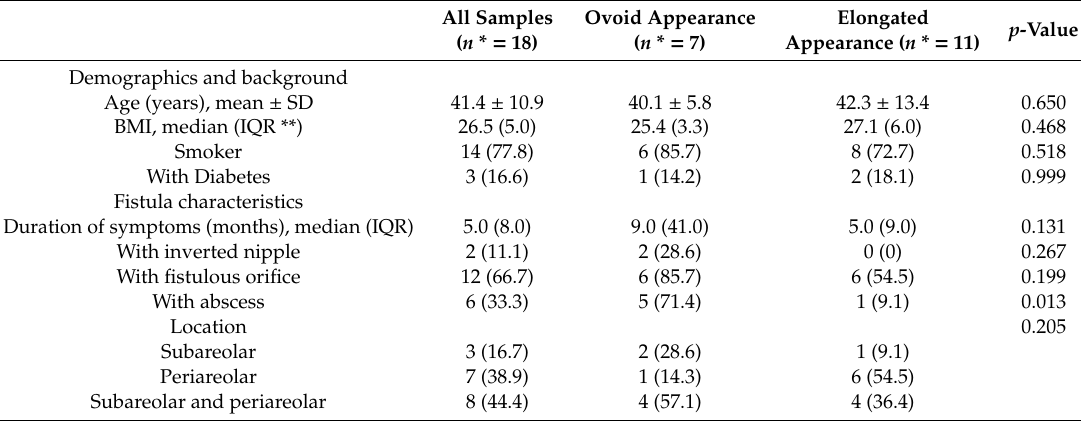
Table 1. Characteristics of all participants and by fistula appearance on